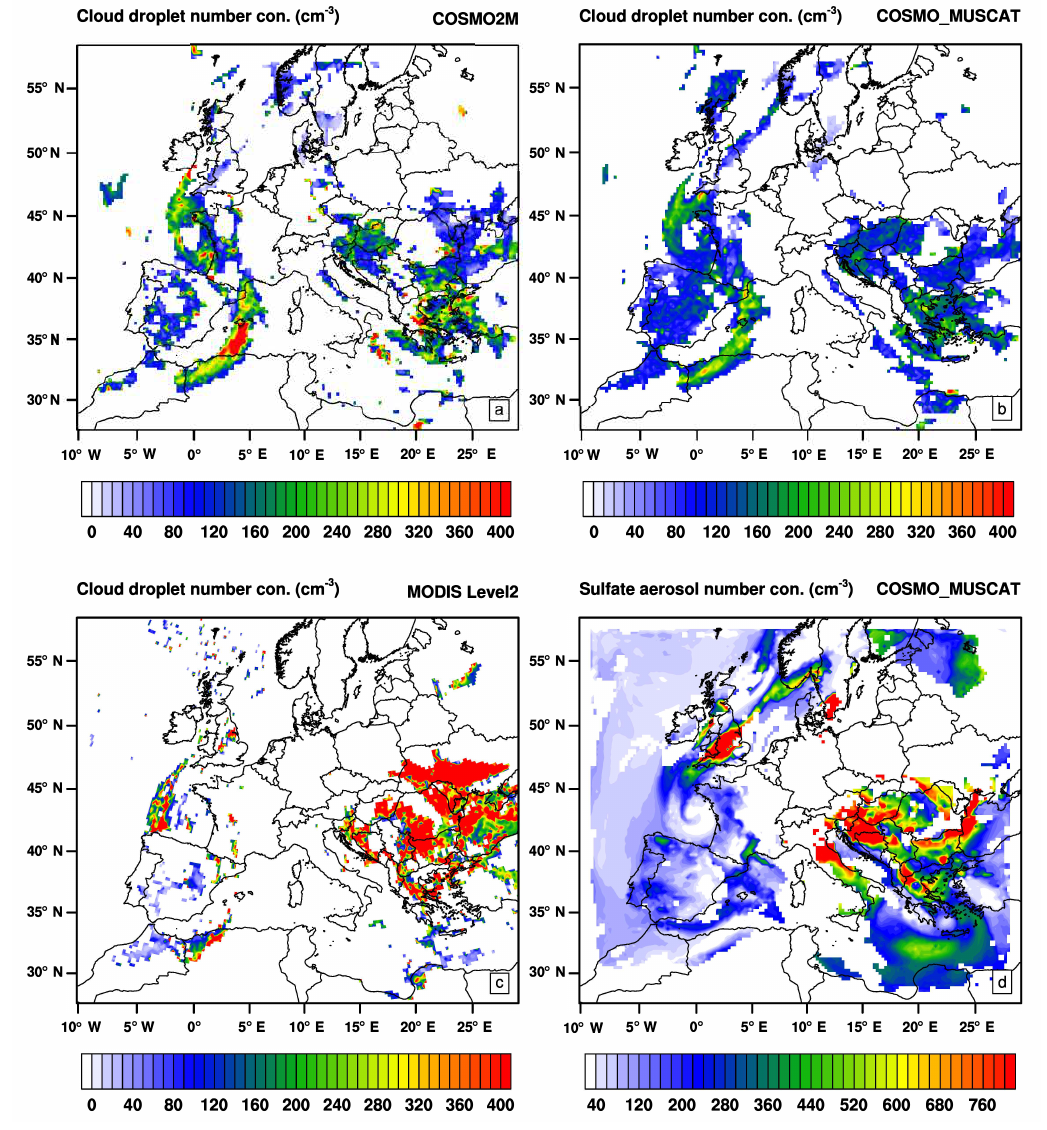
Figure 6. Cloud droplet number concentration (averaged between 08:00 and 14:00UTC – MODIS Terra overpass time over the domain) for (a) COSMO2M, (b) COSMO-MUSCAT, (c) MODIS level-2, and (d) sulfate aerosol number concentration below the convective cloud base from the MUSCAT model for 17 February